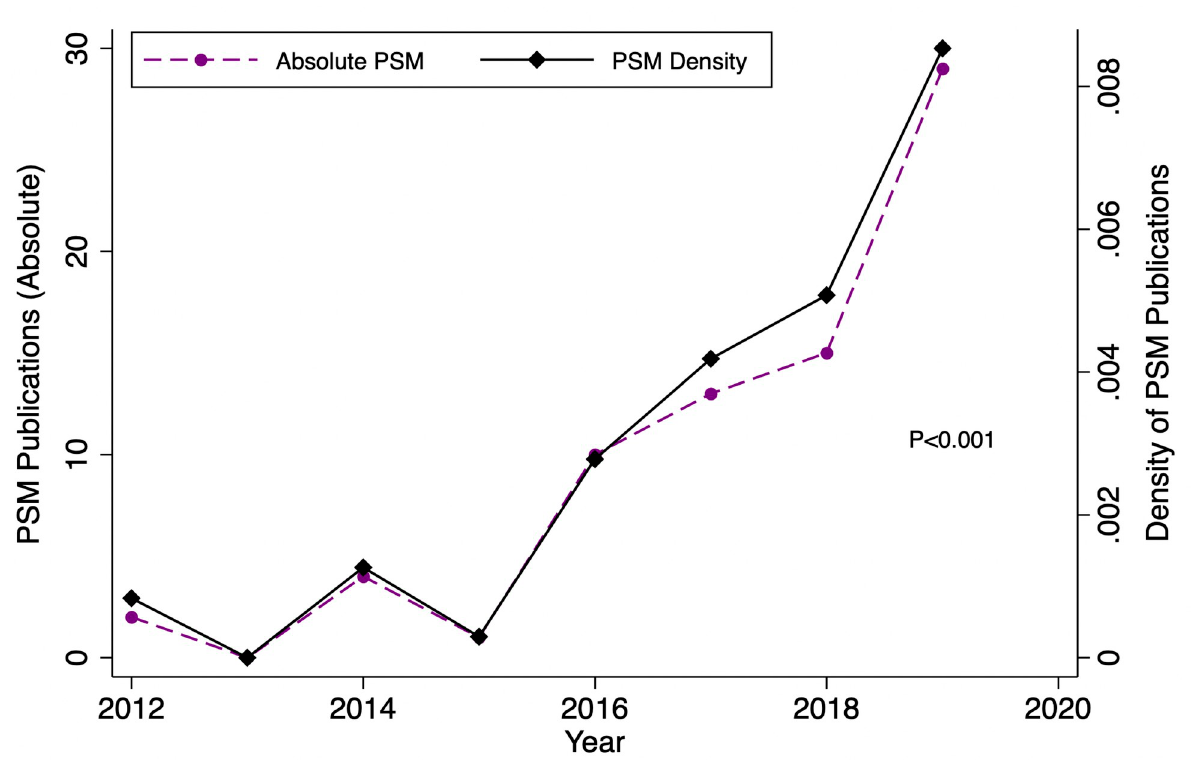
Fig 2. Trend analysis depicting the absolute and relative increase in the number of studies using PSM methodology over time.